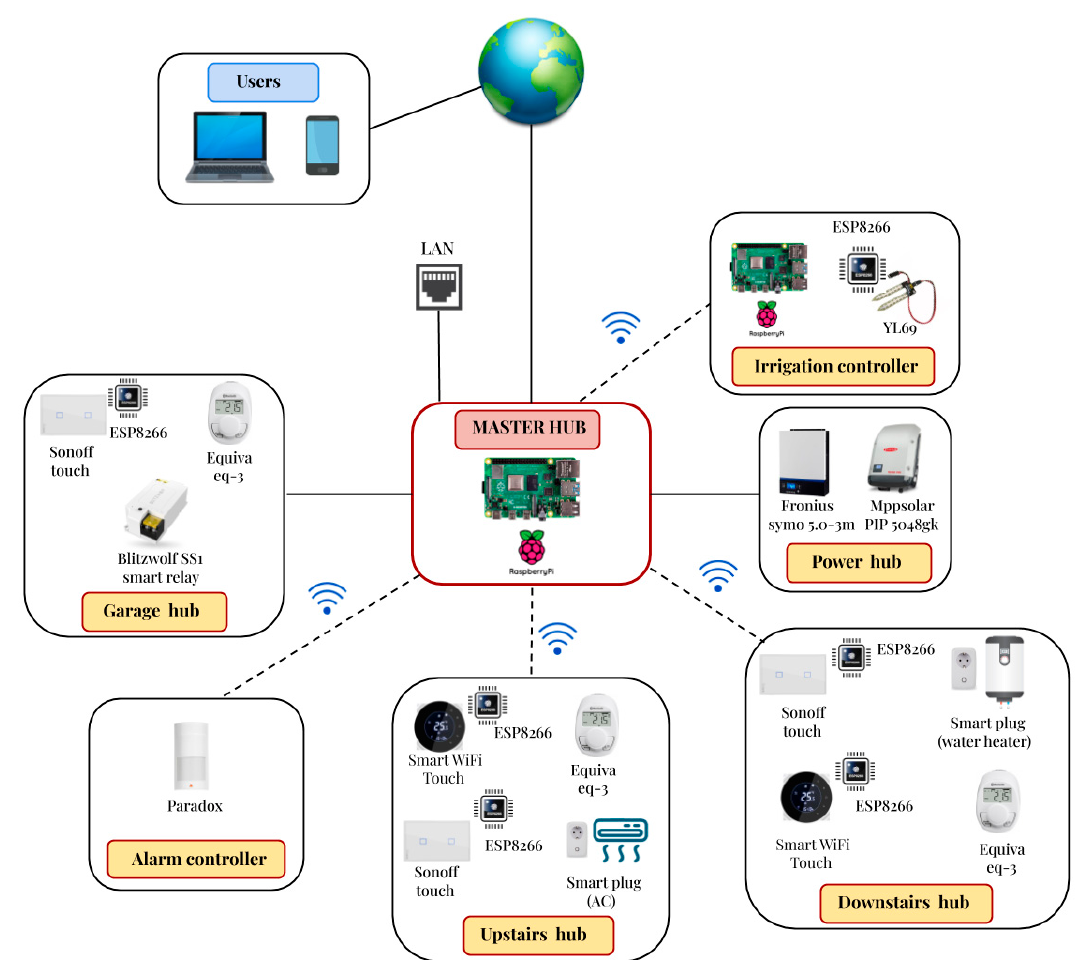
Figure 14. qToggle arhitecture for the presented case study.